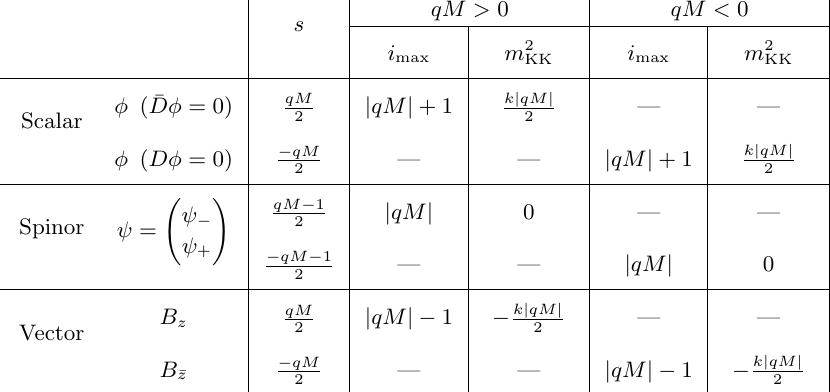
for the lowest wavefunctions KK